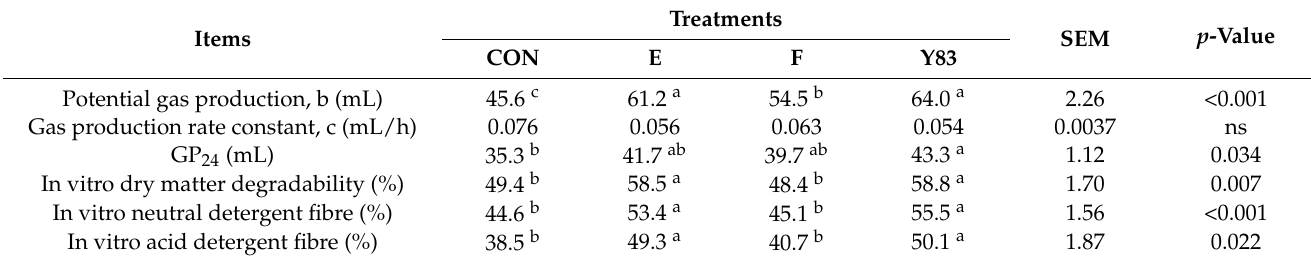
Figure 2. Gas production profiles (mL/g dry matter) from in vitro fermentation of rice straw silage for 72 h. Abbreviations: CON, control; E, fibrolytic enzyme; F, Trichoderma reesei ; and Y83, Enterococcus faecium Y83. Table 4. Gas production kinetics, in vitro dry matter digestibility, in vitro neutral detergent fibre and in vitro acid detergent fibre of rice straw silages after 60 days of